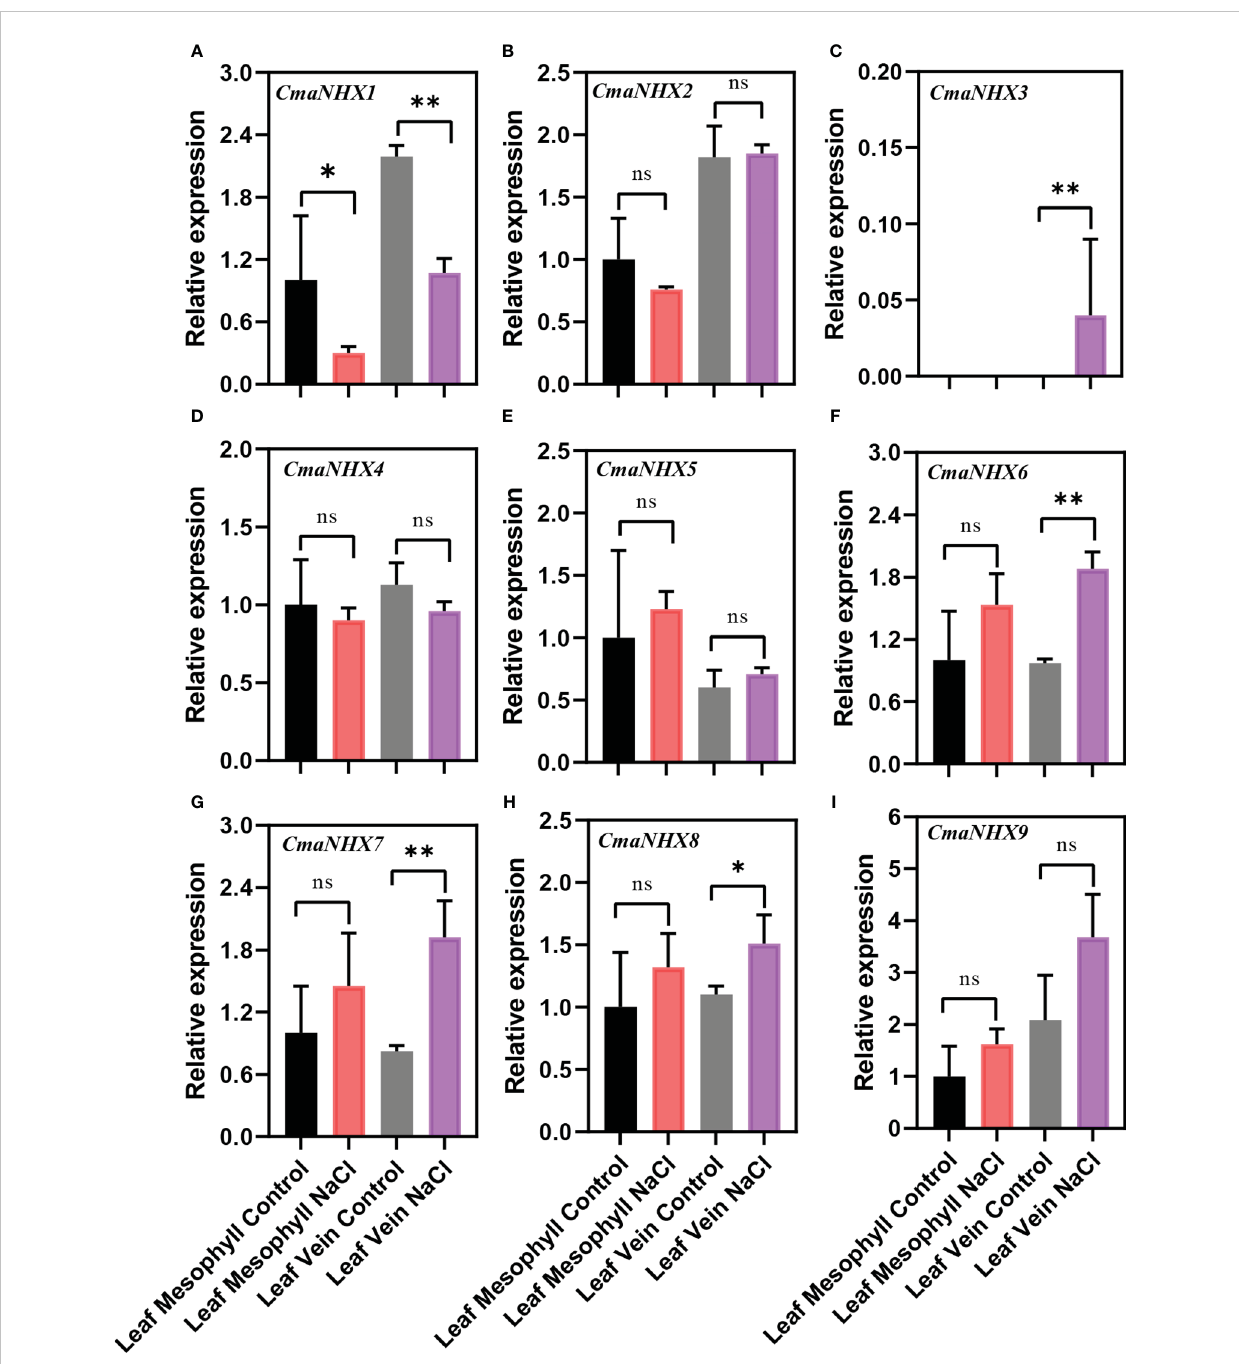
FIGURE 7 Relative expression of NHX genes from the leaf mesophyll and leaf veins of C. maxima ( ‘ Rimu ’ ) in response to treatment with 100 mM NaCl for 24 h. Each data represents the average from three samples. The error bars represent the SDs. ∗ indicates signi fi cance at p < 0.05, ∗∗ indicates signi fi cance at p < 0.01, NS indicates no signi fi